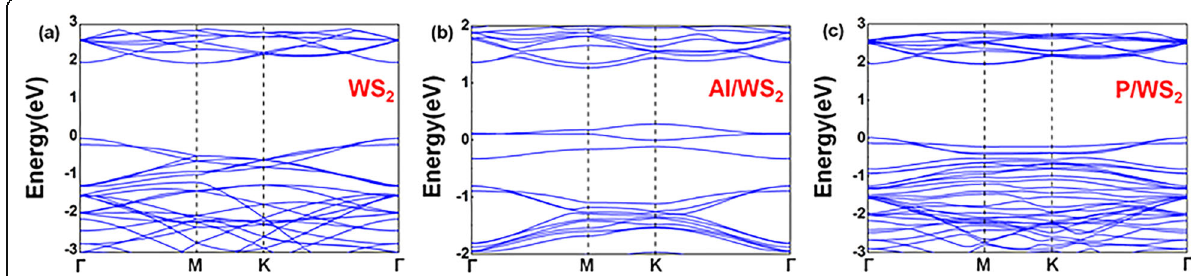
Fig. 2 Band structure of a pristine WS 2 , b Al-doped WS 2 , and c P-doped WS 2